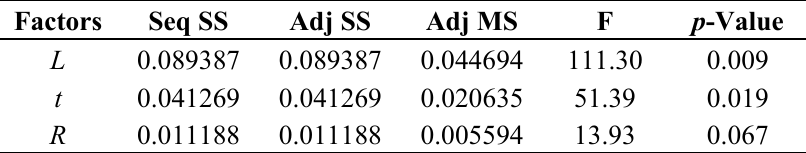
Table 7. Analysis of variance for energy absorbed per unit